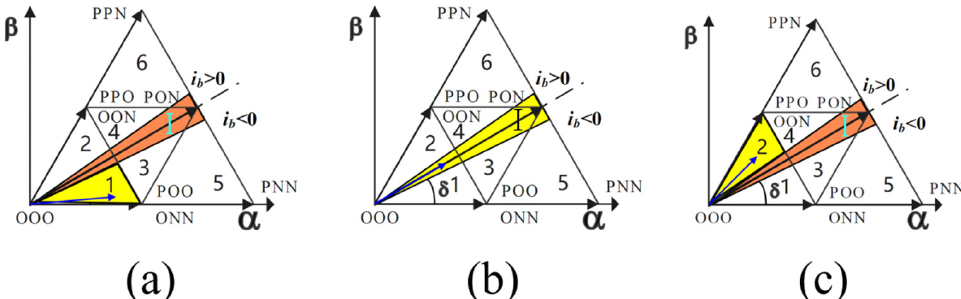
Figure 9. Operation of reference voltage vector in sectors 1 and 2. ( a ) The reference voltage vector is in the undistorted region of sector 1. ( b ) The reference voltage vector is in the distortion region I. ( c ) The reference voltage vector is in the undistorted region of sector 2. Table 3. Modulation method, clamping method and corresponding switching sequence of sectors 1 and